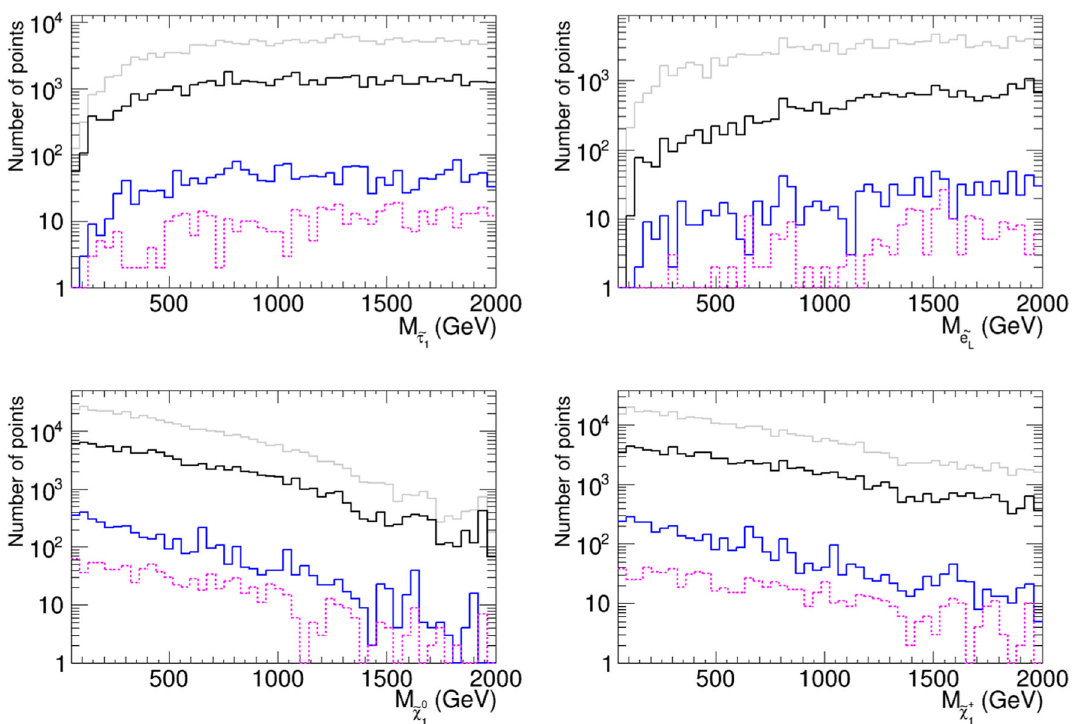
Fig. 2 Distributions of sparticle masses in our scan of the MCPMFV pMSSM(continued).Upperleft:Thelighterstaumass,upperright:left- handed selectron mass, lower left: lightest neutralino mass, lower right: lighter chargino mass. Grey histograms: all points passing the LEP and